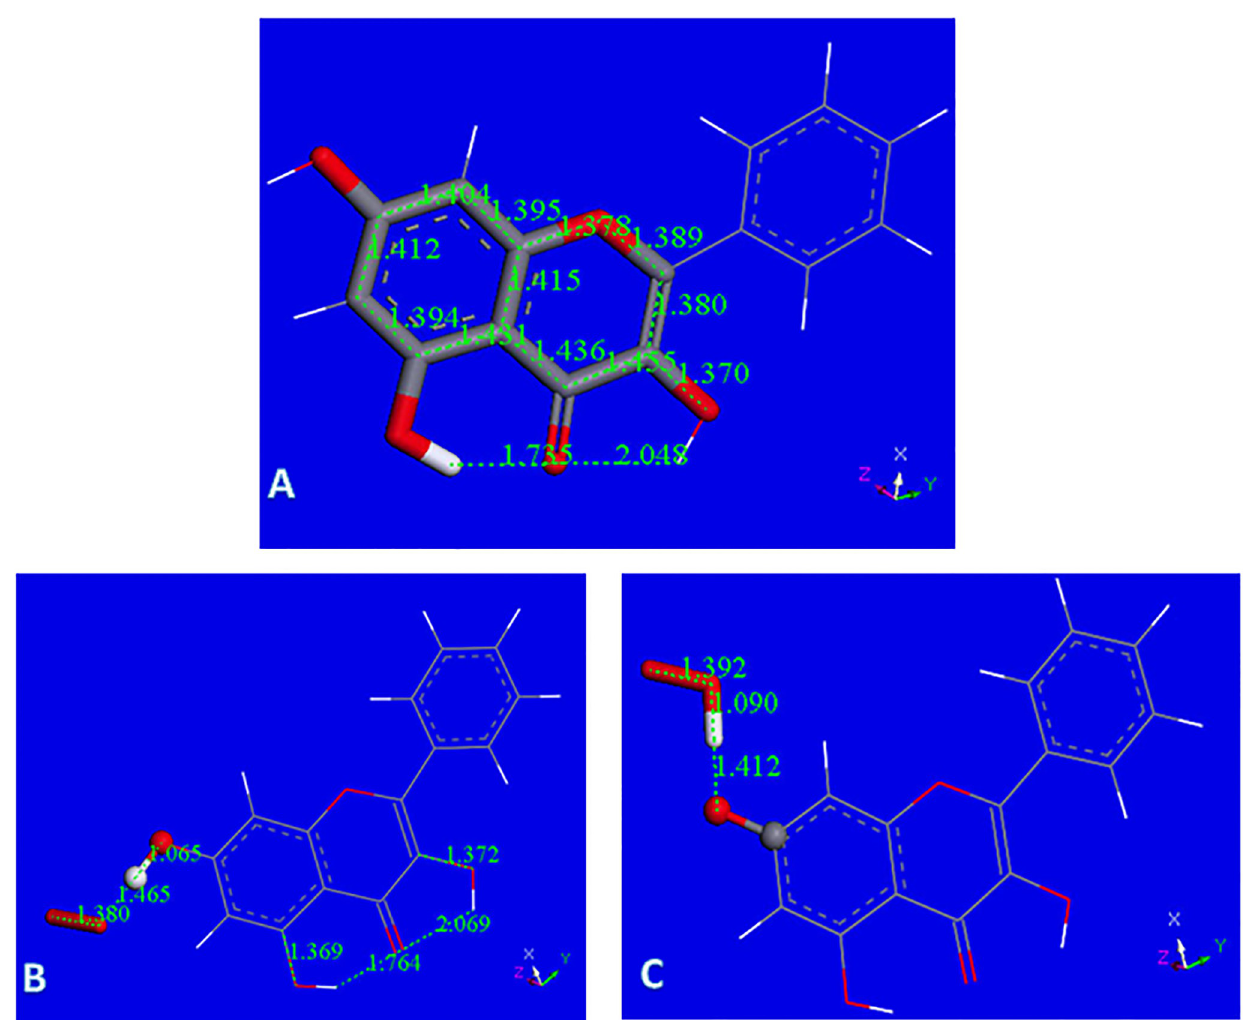
Fig 3. A: Galangin geometry obtained from X-ray coordinates after DFT minimization; B: Initial van der Waals separation between H7 and superoxide, 2.60 Å , decreases to 1.465 Å after DFT minimization, while hydroxyl separation is still a bond length, 1.065 Å . Superoxide: stick style; galangin 7-OH: ball and stick style; C: H7 was eliminated from the hydroxyl and the remaining species, the galangin radical, was DFT minimized and later placed 2.60 Å from HO 2 for further geometry minimization. Fig 3C shows the converged energy minimum: the H atom of HO 2 is not recaptured by the galangin radical, 1.412 Å . The energy of this minimum is 1.7 kcal/mol higher than that in Fig 3B, suggesting H7 of galangin is not captured by